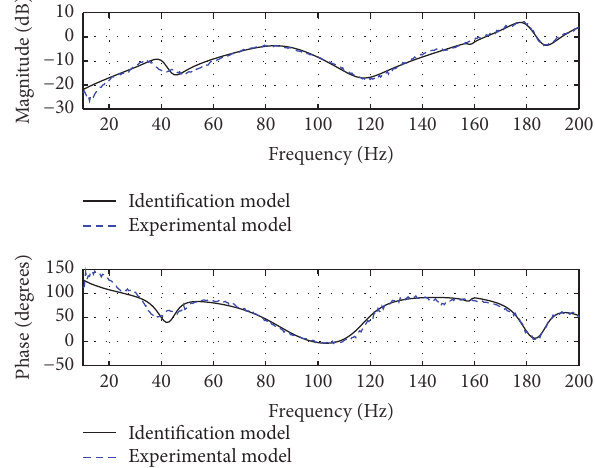
Figure 3: Frequency response curves of VA12 experiment model and identification system model.